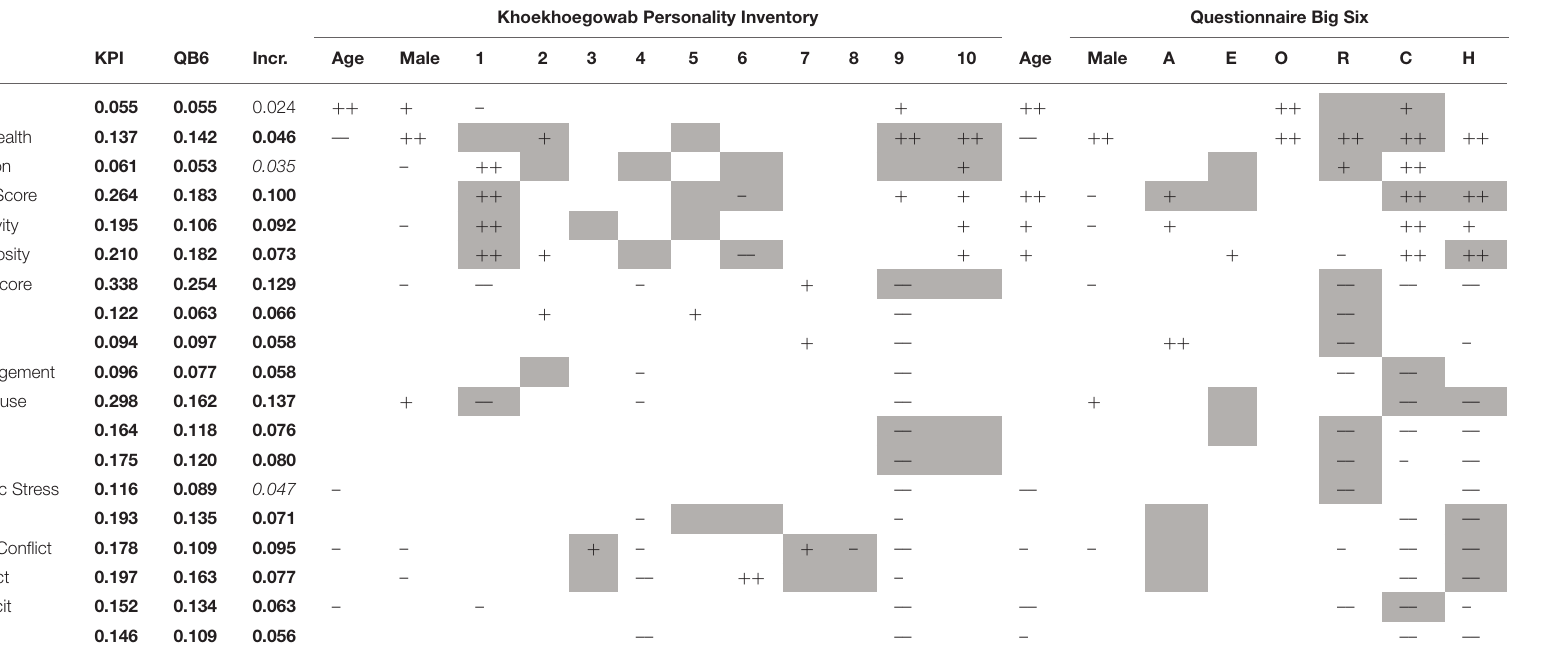
TABLE 5 | R-Square Change for Criterion Variables After Age, Gender for Inventories as a Whole, Indicating Significant Coefficients by